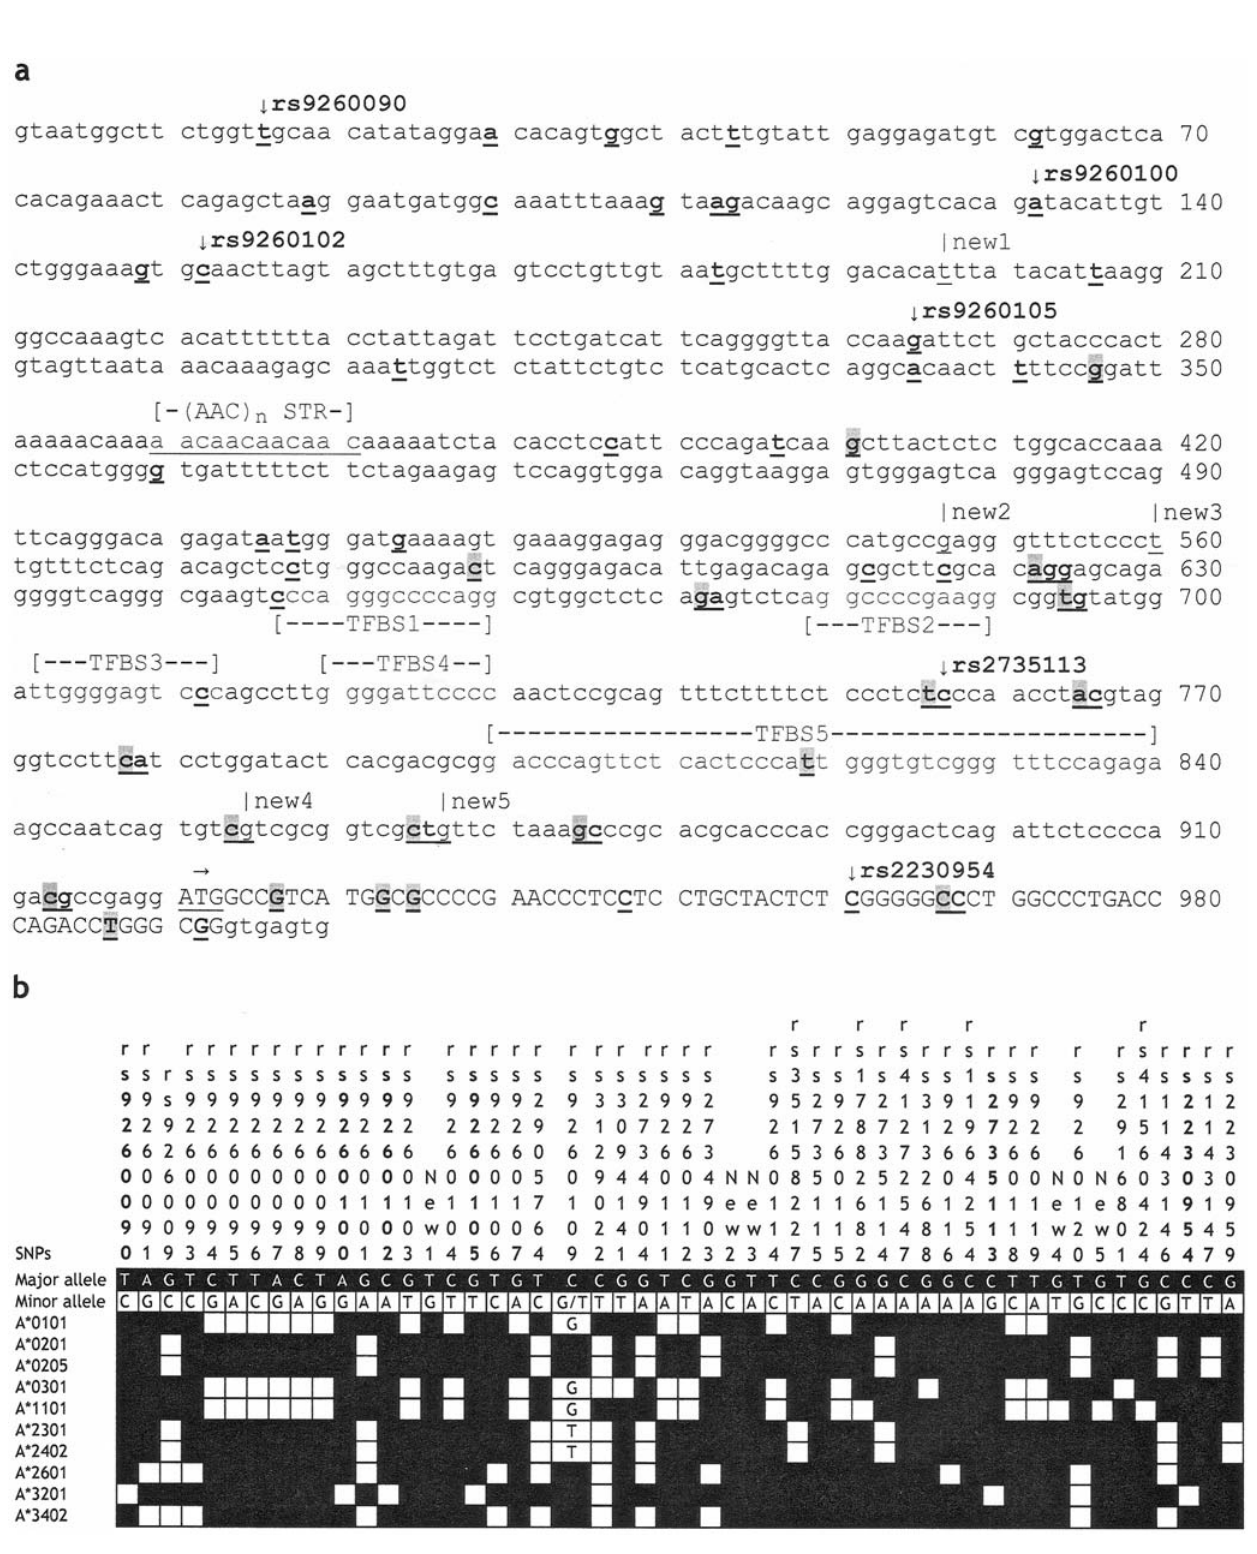
Figure 1. DNA polymorphisms within HLA-A promoter and exon 1 sequences. A 1000-bp region (Panel a) has been sequenced for select population samples. Upper case letters are cDNA sequences (part of the open reading frame); the translation start codon (ATG) is indicated by a horizontal arrow. STR denotes a short tandem repeat sequence that has either three or four AAC repeats. Five transcription factor-bindings sites (TFBS) are also indicated. Within this fragment, 69 single nucleotide polymorphisms (SNPs) ( bold and underlined) have already been reported in the literature. Those ( n =19) not confirmed in this work are shaded grey. The five novel SNPs are designated as ‘‘New’’ (underlined nucleotides below vertical lines). The SNPs unique to A*3201 are marked by vertical arrows before their respective reference sequence (rs) numbers (from dbSNP database, version 126). In panel b, 53 informative SNPs (minor allele frequency $ 0.02) are linked to 11 HLA alleles found in homozygous state.